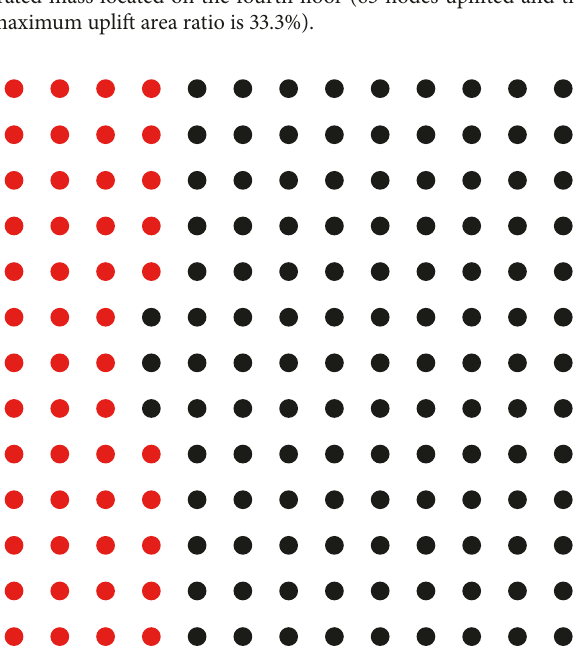
Figure 36: Schematic diagram of uplifted nodes under the concen- trated mass located on the first floor (49 nodes uplifted and the maximum uplift area ratio is